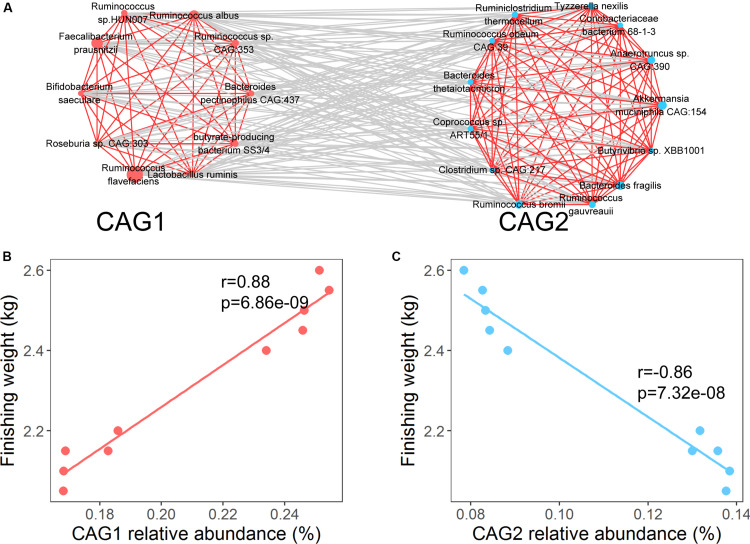
Interactions among the species responding for finishing weight. (A) The interaction network of finishing weight-associated species. The red nodes represent positively associated species and the blue nodes represent negatively associated species. The node size indicates the average relative abundance of each species. Lines linked to nodes indicate significant correlations among the species (FDR adjusted P < 0.05, |r| > 0.45), with red and gray colors showing positive and negative correlations, respectively. The species are clustered into two co-abundance groups (CAGs) by PERMANOVA at P < 0.05. (B) The association of the abundance of CAG 1 with finishing weight. (C) The association of the abundance of CAG 2 with finishing weight.